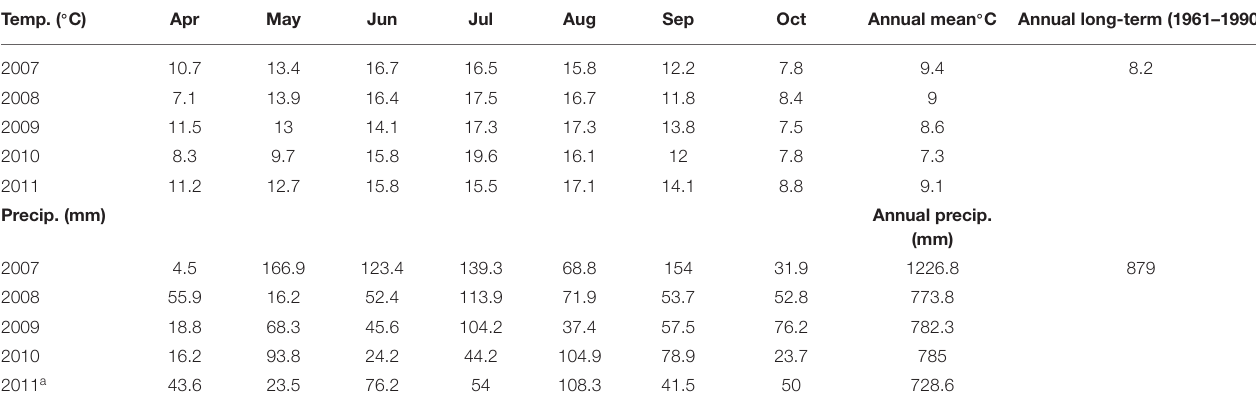
TABLE 2 | Proportions of plant functional groups and species richness as affected by sward-type (gd, grass-dominated; div, diverse sward) and grazing system (mono-grazing with cattle (C) and sheep (S) vs. mixed-grazing of cattle and sheep (CS) averaged over years 2007–2011 (means ± sd). Sward type gd div Grazing system Mono Mixed Mono Mixed Livestock Grasses